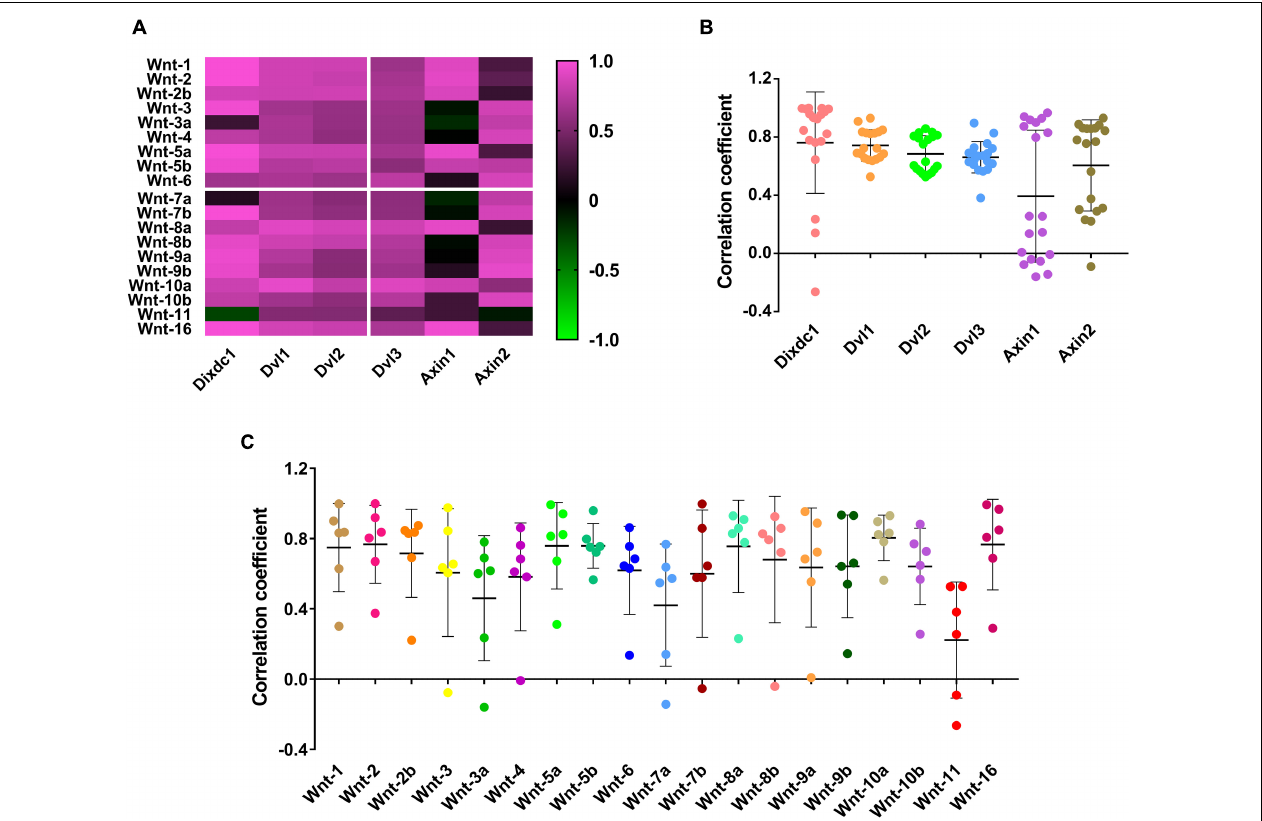
FIGURE 6 | Wnt and DIX were co-evolved protein families. (A) The co-evolution correlation matrix between 19 Wnt proteins and 6 DIX proteins. (B) The scatter plots exhibit the Wnt-DIX co-evolution correlation of six DIX members. (C) The scatter plots exhibit the Wnt-DIX co-evolution correlation of 19 Wnt members.